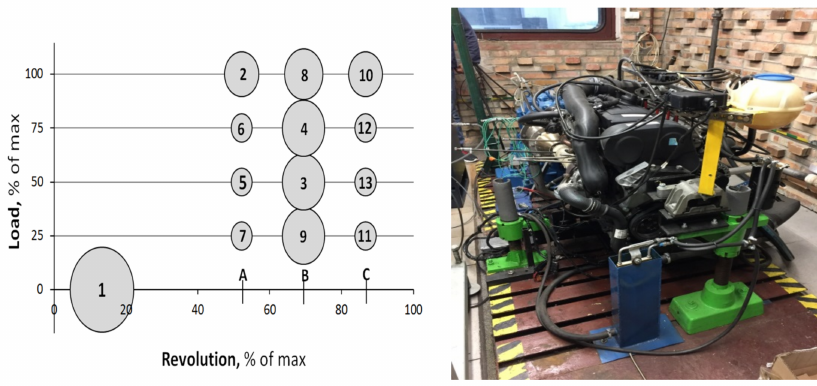
Figure 2. European Stationary Cycle (ESC), 13 modes test, and research position.